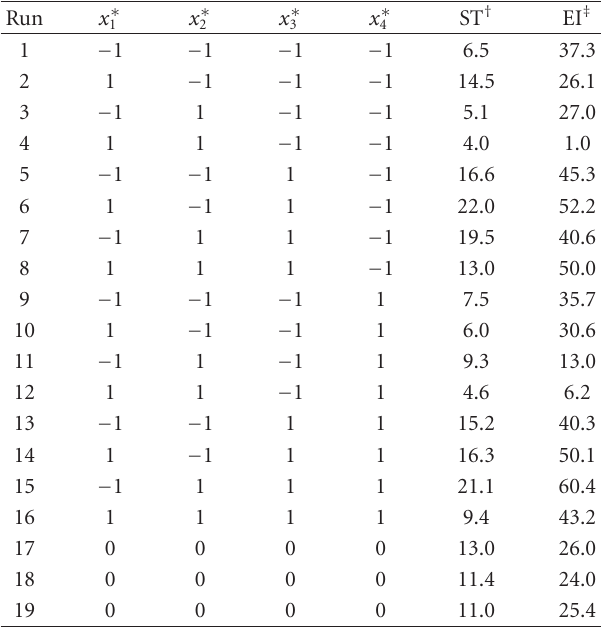
Table 3: Experimental design and results of the 2 4 full factorial design for nitrogen source